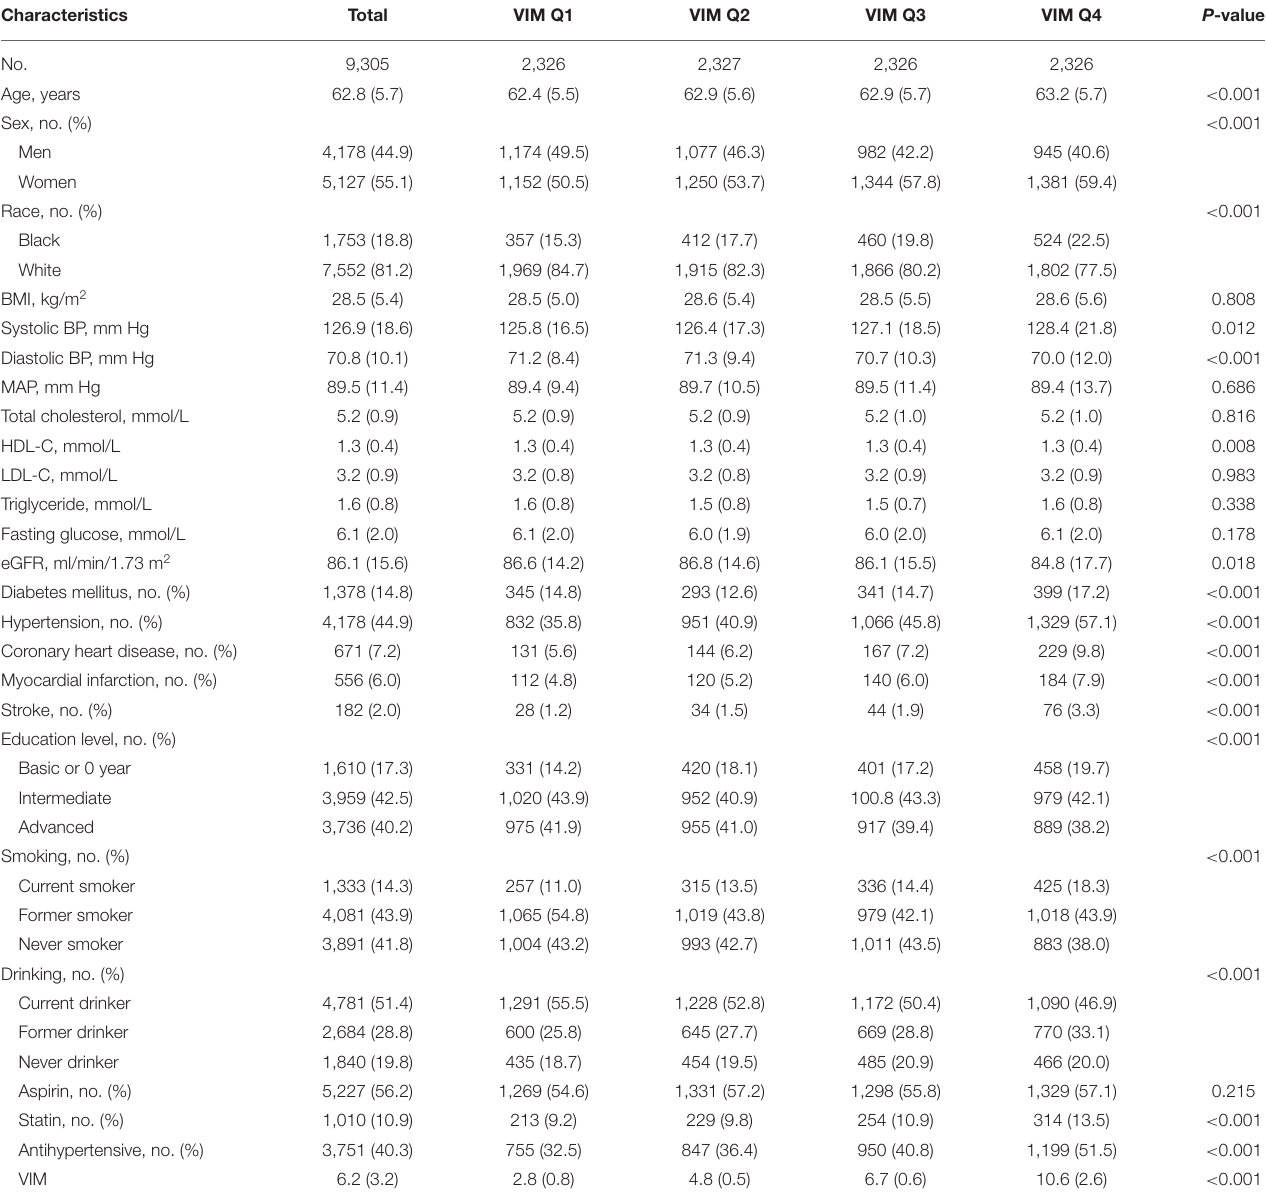
TABLE 1 | Characteristics of each group categorized by the VIM of MAP at visit 4.